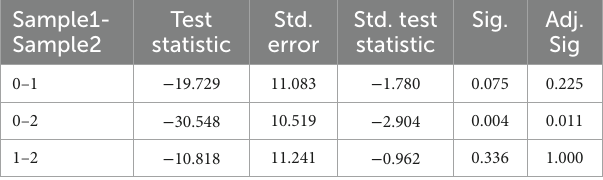
TABLE 13 Paired comparison results ( Adaptability ). Sample1- Test Sample2